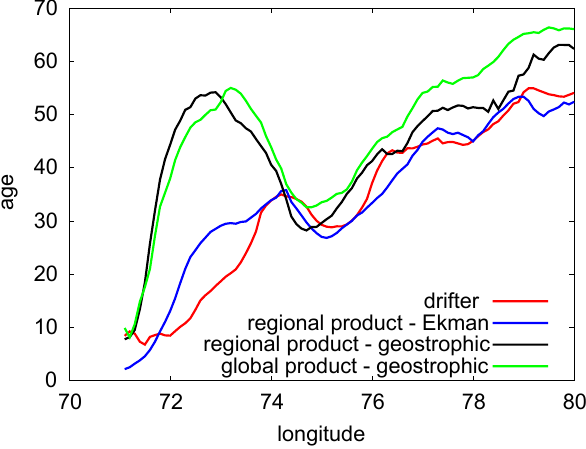
Figure 8. Age from the plateau averaged in latitude along a band 48 ◦ S:50 ◦ S for different altimetry-based products of surface cur- rents and for SVP drifters. The general trend indicates the mean eastward drift (the age increases with the longitude). Note the local maximum at 72 ◦ E:75 ◦ E – which indicates a recirculation region – remarkably reproduced by the altimetry regional product which includes Ekman